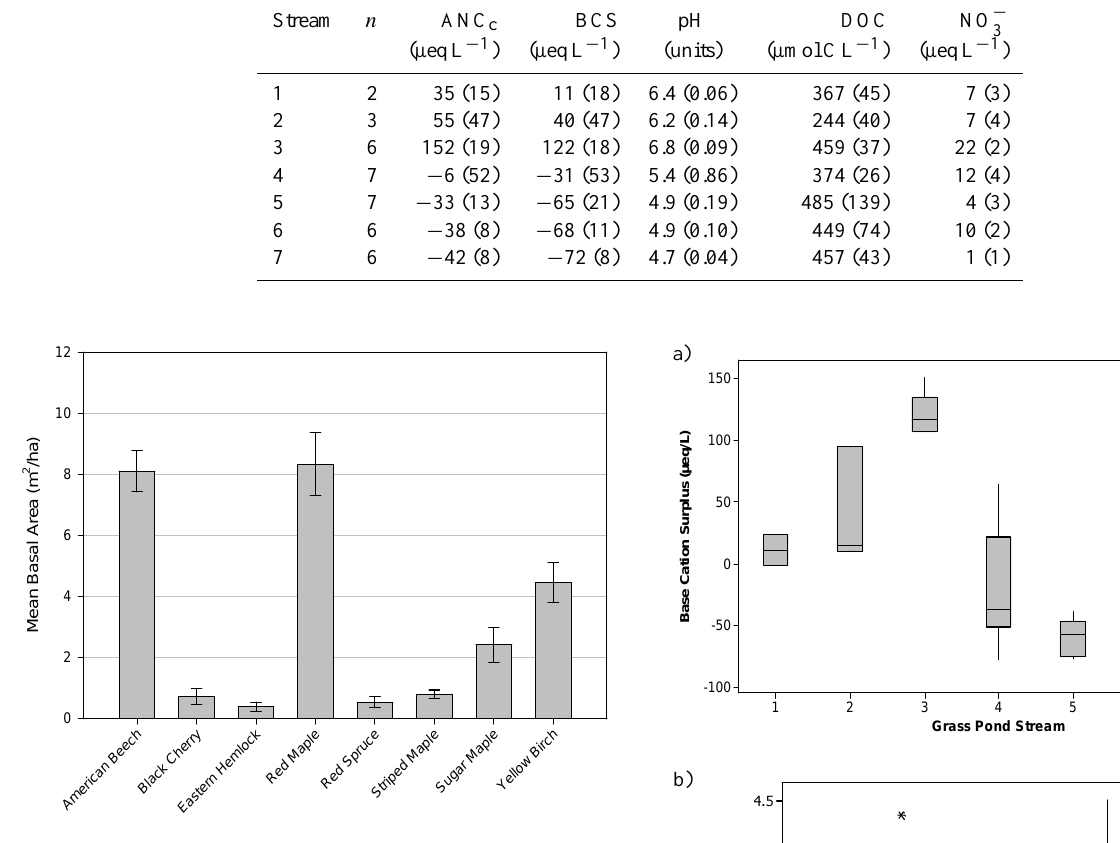
Figure 2. Grass Pond watershed mean tree species total basal area (m 2 /ha) calculated from plot Fig. 2. Grass Pond watershed mean tree species total basal data collected August-October 2008. Bars indicate one standard error. area (m 2 ha − 1 ) calculated from plot data collected August– October 2008. Bars indicate one standard error.